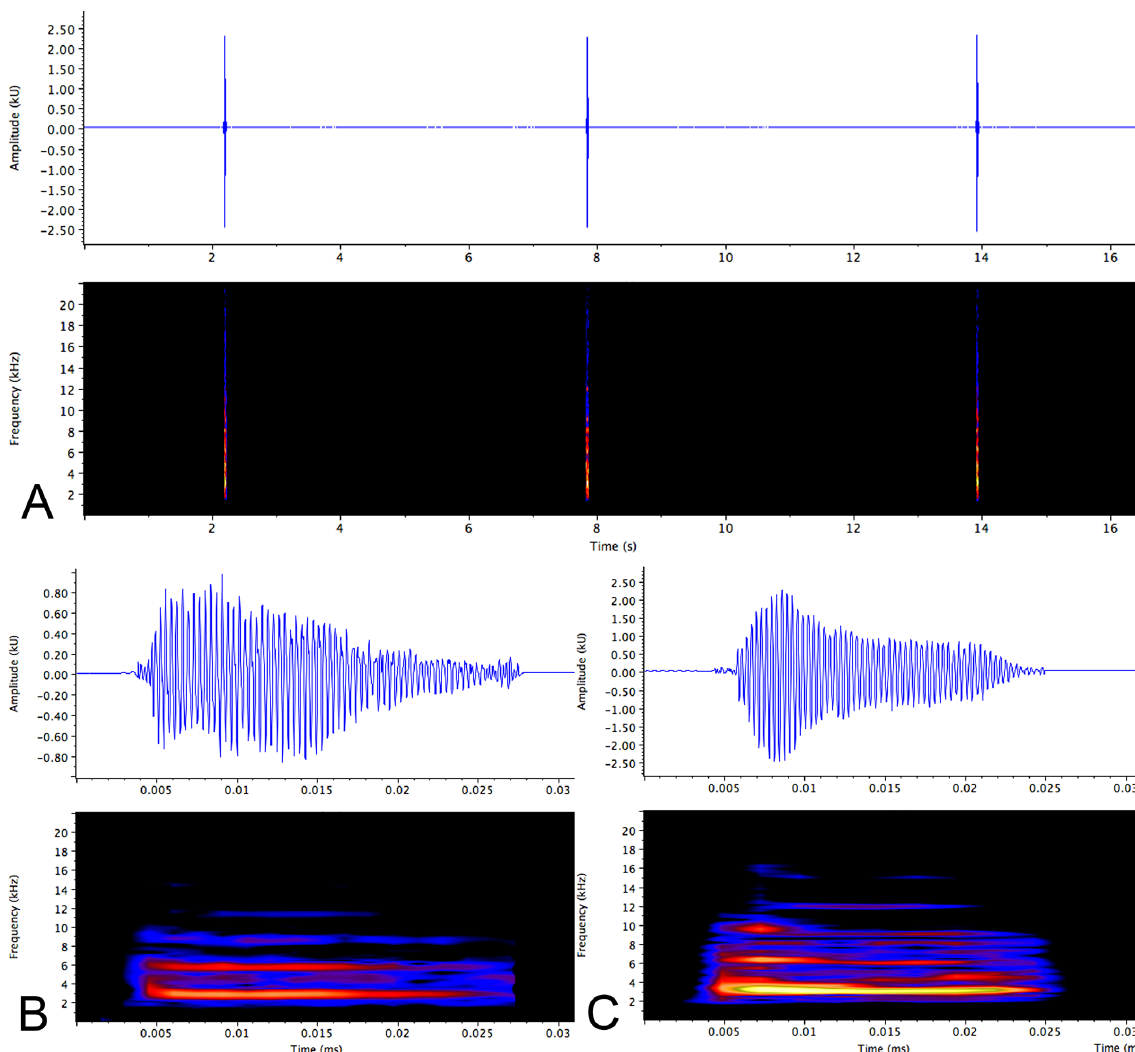
Fig. 7. Vocalization of Pristimantis marmoratus (Boulenger, 1900); oscillograms and spectrograms obtained using Raven v. 1.4. A . Oscillogram (top) and spectrogram (below) of three calls of IRSNB 14472 from Kaieteur National Park, Guyana (ca 16 s recording). B . Expanded oscillogram (top) and spectrogram (below) of one call of IRSNB 14471 from Kaieteur National Park, Guyana. C . Expanded oscillogram (top) and spectrogram (below) of one call of IRSNB 14472 from Kaieteur National Park, Guyana. Calls recorded at a temperature of